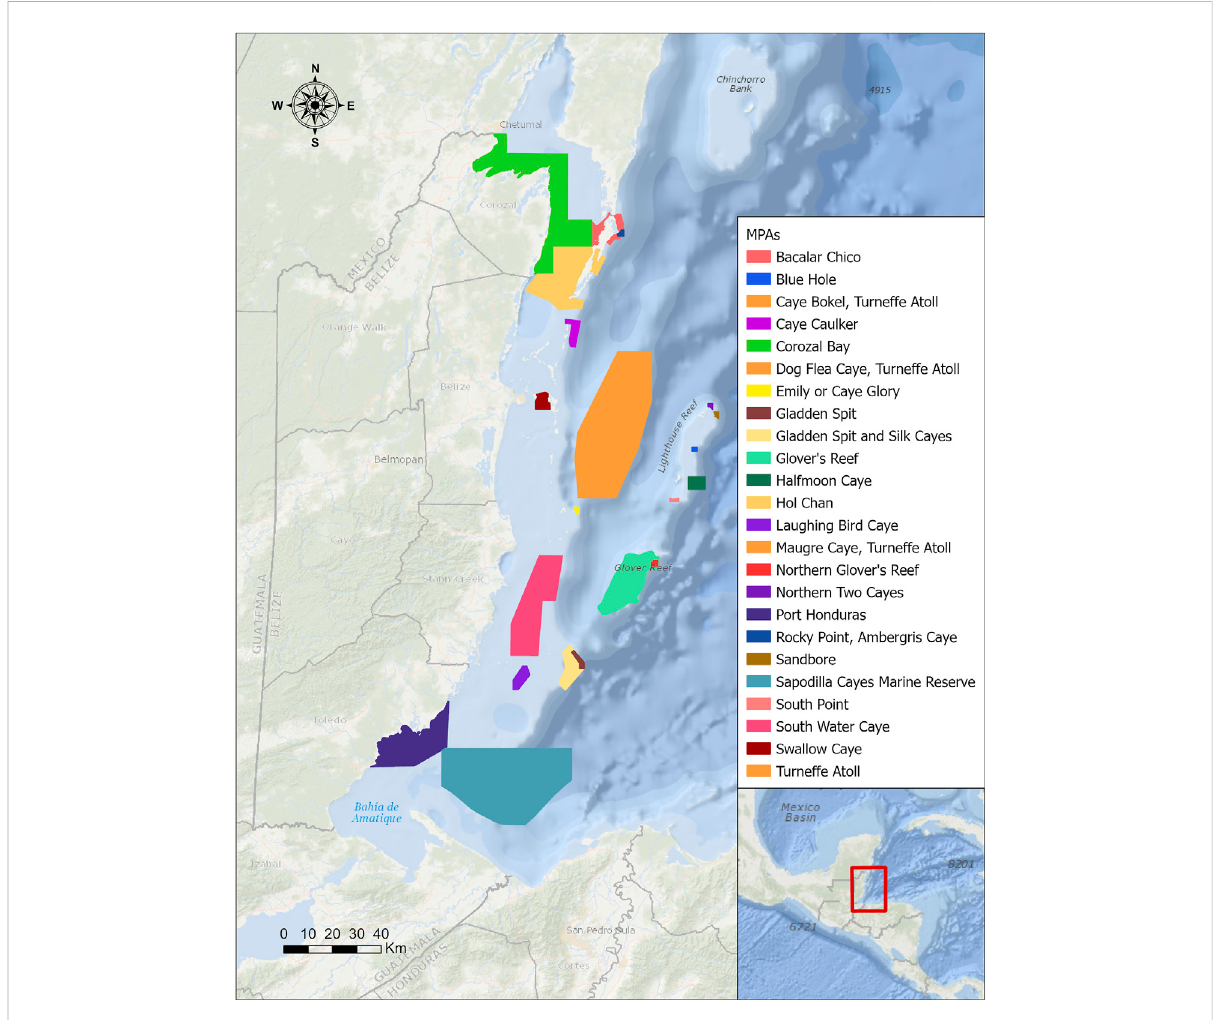
FIGURE 2 Map of Belize showing the 24 Marine Protected Areas (MPAs) created with the goal of conserving biodiversity. A variety of habitat designations are present, including fi shing and spawning, general use, mangrove, marine and coral reefs, preservation, and special management.